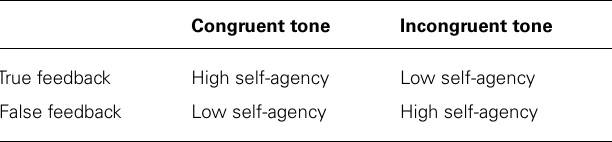
Table 1 | Hypothesized sense of agency as a function of feedback validity and tone congruency with the action